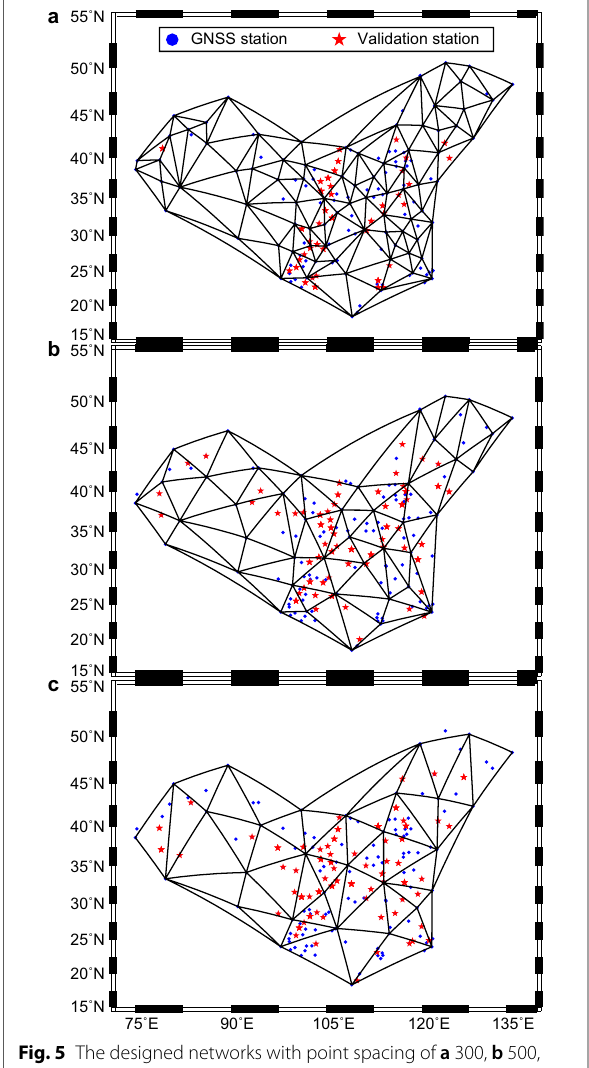
Fig. 5 The designed networks with point spacing of a 300, b 500,